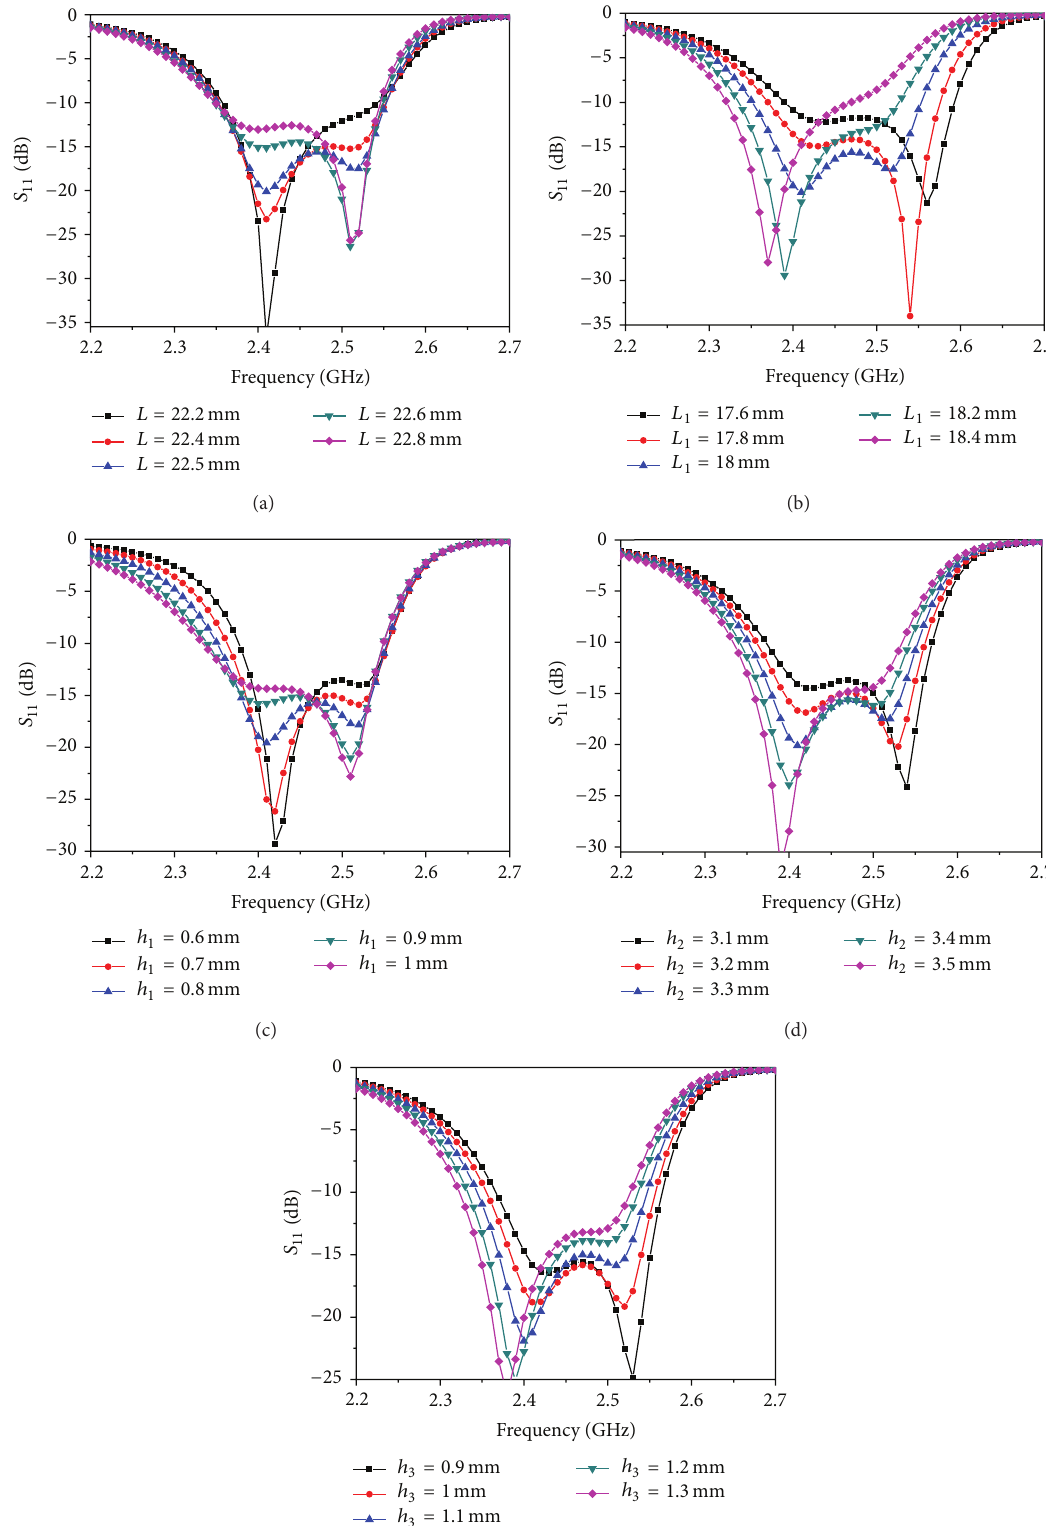
Figure 4: 𝑆 11 characteristics, (a) lower patch 𝐿 variation, (b) upper patch 𝐿 1 variation, (c) thicknesses of the LTCC substrate under the lower patch of the antenna variation, (d) separations of the lower and upper patches variation, and (e) thicknesses of the superstrate